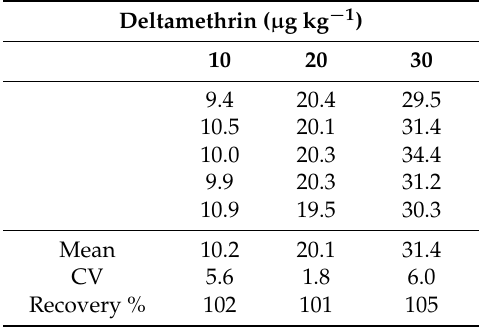
Table 2. Intra-assay variations in goat milk samples ( n = 5, fortified at 10, 20 and 30 µ g kg − 1 ).